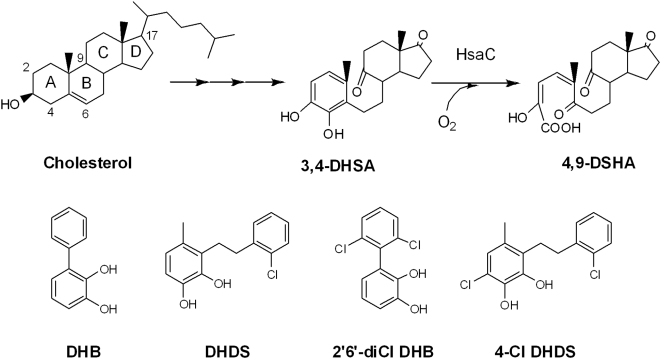
The role of HsaC in the cholesterol degradation pathway.Cholesterol is transformed to DHSA (3,4-dihydroxy-9,10-seconandrost-1,3,5(10)-triene-9,17-dione) via multiple enzymatic steps. HsaC catalyzes the extradiol ring-cleavage of DHSA to DSHA (4,5-9,10-diseco-3-hydroxy-5,9,17-trioxoandrosta-1(10),2-diene-4-oic acid).